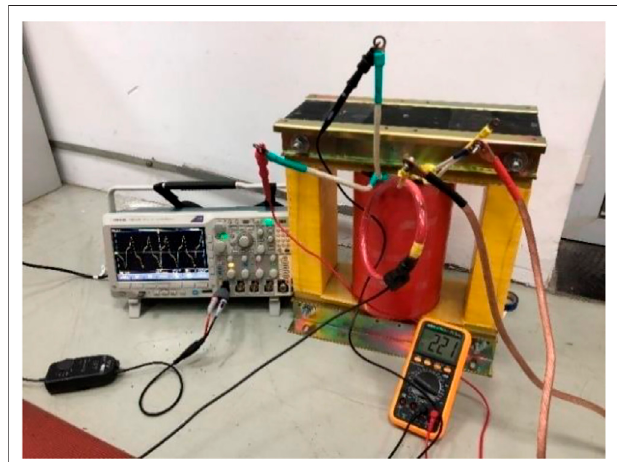
FIGURE 13 | Transformer no-load